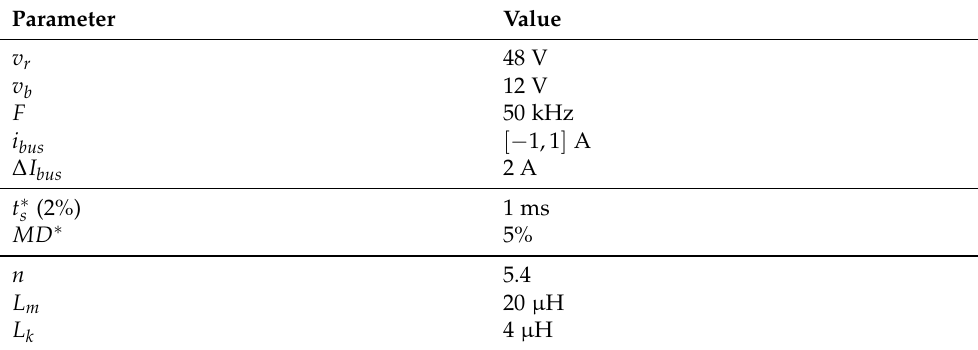
Table 1. Parameters of the application